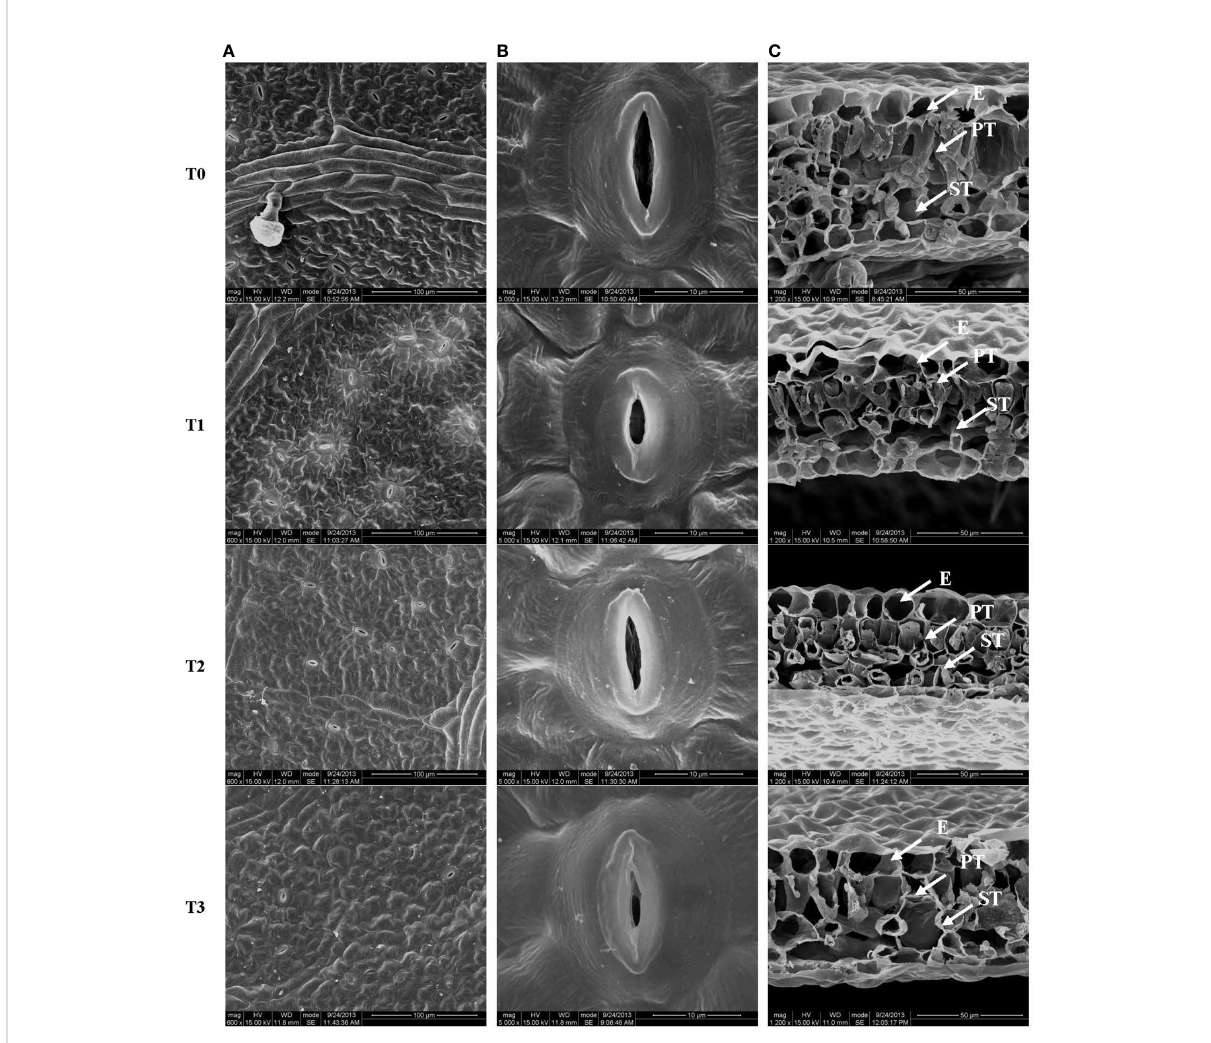
FIGURE 2 Stomatal structure on the leaf surface (A, B) and leaf cross-section (C) from C. betulus leaves under different light intensity treatments (T0~T3). E, epidermis; PT, palisade tissue; ST, spongy tissue. Scale: 100 m m (A) , 10 m m (B) , 50 m m (C)